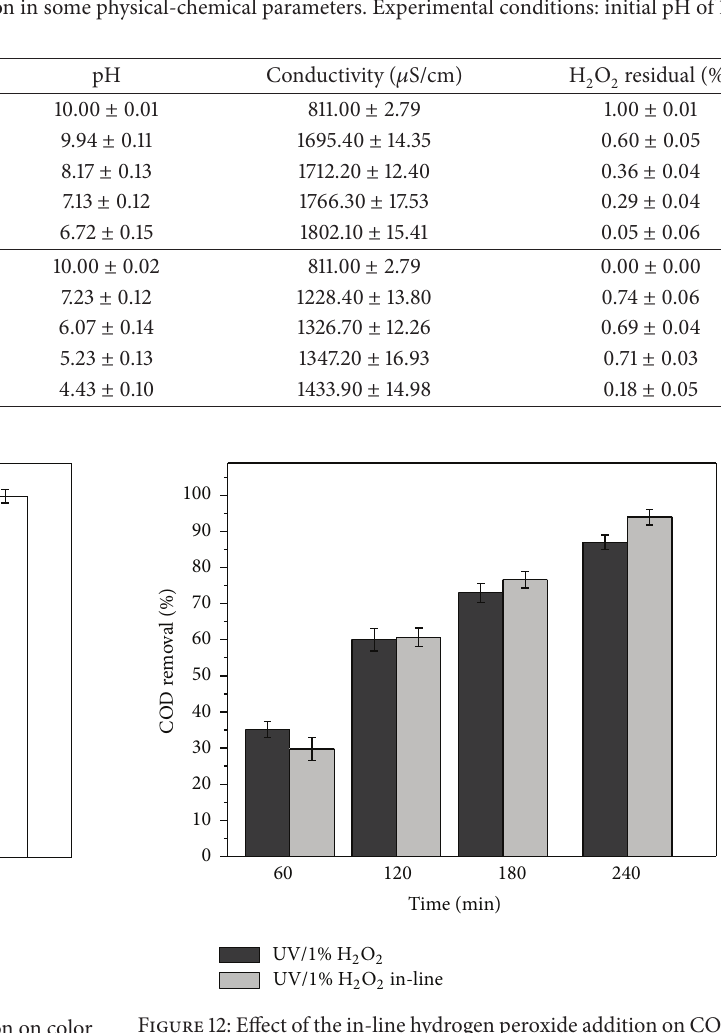
Table 4: Zero order rate constant for RR decolorization under different % H